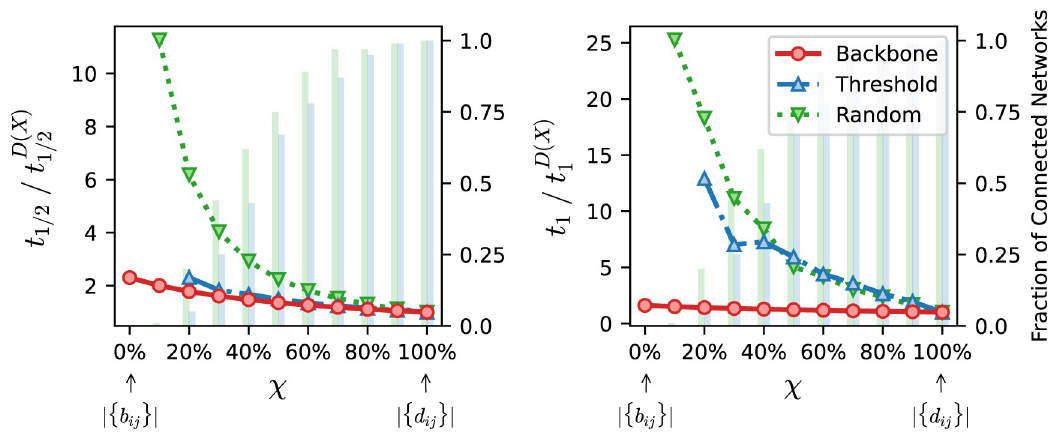
Fig 4. Normalized time to infection using the metric backbone, threshold, or random subgraphs of the French High School (Fr-HS) network. The horizontal axis denotes χ , a parameter to sweep the proportion of edges of the original network that are included in the subgraphs analyzed. When χ = 0% (leftmost value on axis) we have the metric backbone subgraph, or threshold and random subgraphs with the same number of edges as the metric backbone (i.e. |{ b ij }| = τ ( D ).|{ d ij }|, per Eq (6)). As χ increases, edges from the original network that are not on the backbone or same-size threshold and random subgraphs, are progressively added until the original network itself is reached at χ = 100% (see text for more details). ( Left ) Time for half of the population to be infected, t 1/2 , normalized by the results obtained using the entire original network, t D ð X Þ . ( Right ) Time for all nodes in the network 1 = 2 . Spreading times for every curve are to be infected, t 1 , normalized by the results obtained using the entire original network, t D ð X Þ 1 averaged over n = 10 runs of the SI model starting from a random seed node and 100 network realizations obtained via random r edge removals for each value of χ . The green and blue bars, quantified against the right vertical axis in each panel, denote the fraction of networks in threshold and random baseline ensembles that are connected for a given χ . Disconnected networks are discarded to compute the spreading times. For the simulations shown, the spreading parameter was set as β = 0.9/ p max where p max is the largest proximity weight of the original